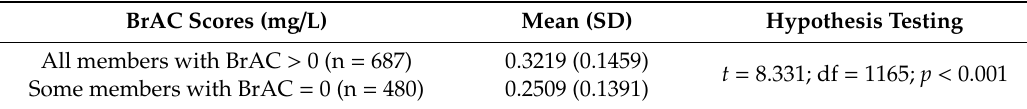
Table 7. Comparison of BrAC by number of peers drinking (for participants with BrAC > 0). BrAC Scores (mg / L) Mean (SD) Hypothesis Testing All members with BrAC > 0 (n = 687) 0.3219